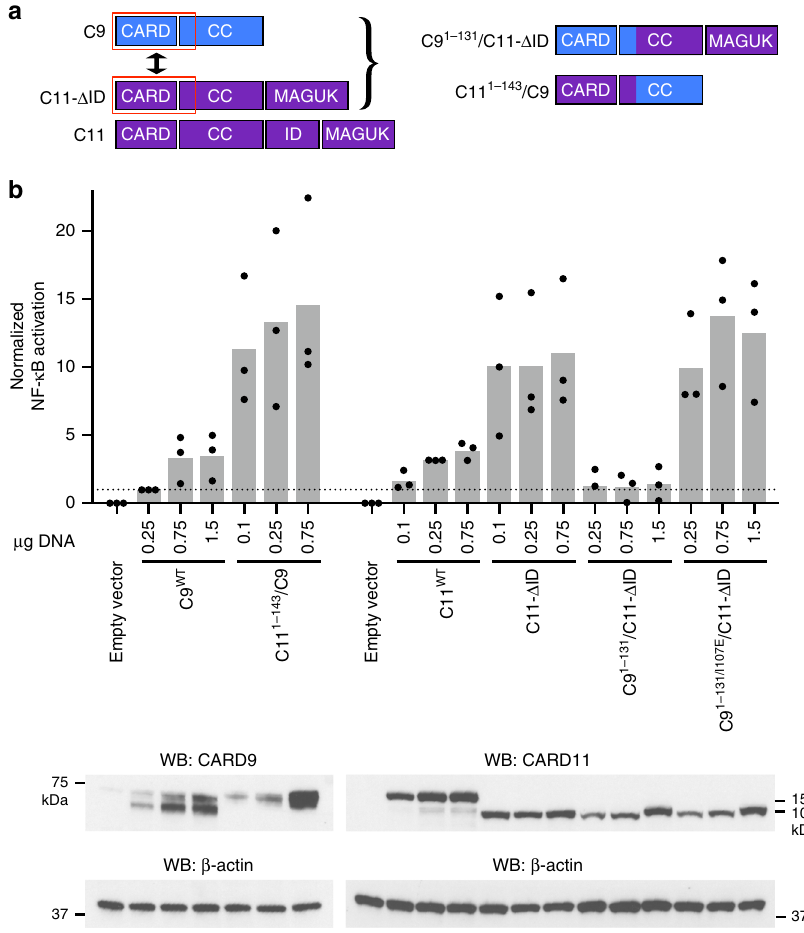
Fig. 3 The CARD11 CARD-coiled-coil interface is weaker than that of CARD9, but is reinforced by the ID. a Cartoon schematic of the domain architecture of CARD9, CARD11- Δ ID, and CARD11 along with the chimeric constructs CARD9 1 − 131 /CARD11- Δ ID and CARD11 1 − 143 /CARD9, wherein the N-terminal residues comprising the CARD, linker, and CARD-interacting stretch of the coil-coil are swapped between the two proteins (See Supplementary Fig. 1B). b Normalized NF- κ B activation in HEK-293 cells upon overexpression of the indicated constructs. Three biologically independent experiments were undertaken, the outcomes of which are shown as dots. The mean value for each construct is depicted as a gray bar. Dotted line represents the value of the CARD9 WT construct, to which the other values were normalized. Representative western blot is shown for CARD9 and CARD11 constructs, using antibodies speci fi c for regions outside of the N-terminal swapped domain or ID. Source data are provided in Source Data fi